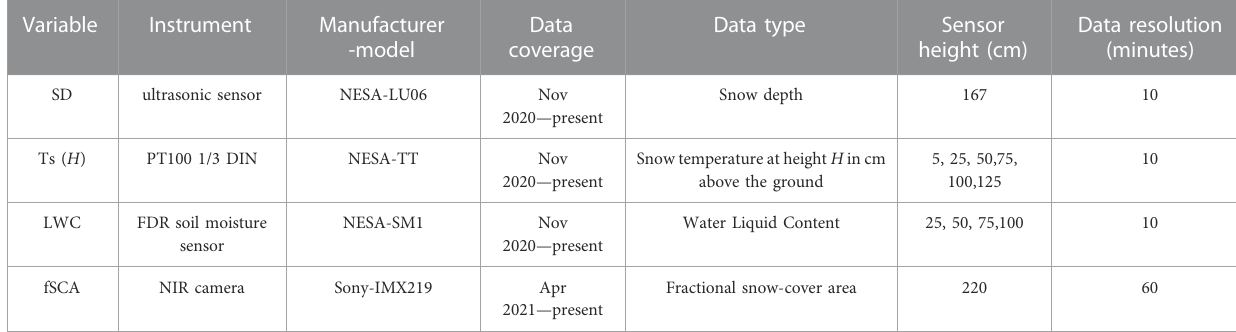
TABLE 1 Description of the instrumental set-up installed on the ANS updated to 2021.